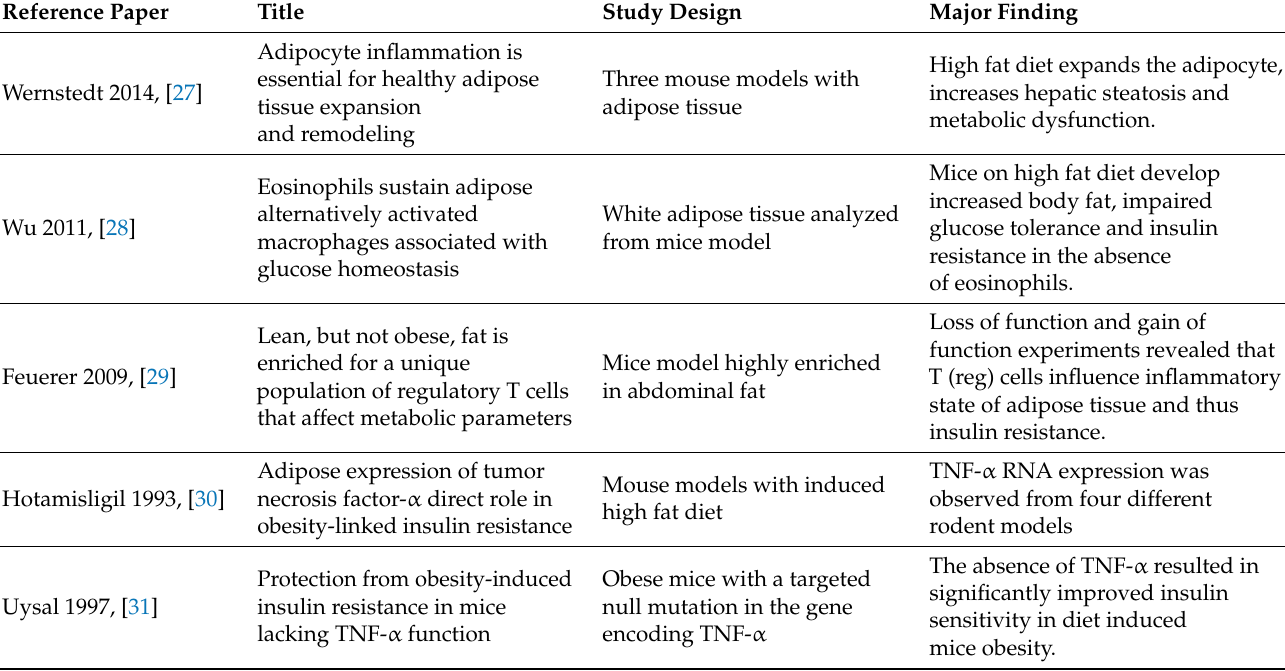
Table 2. Summary of Obese animal models publish